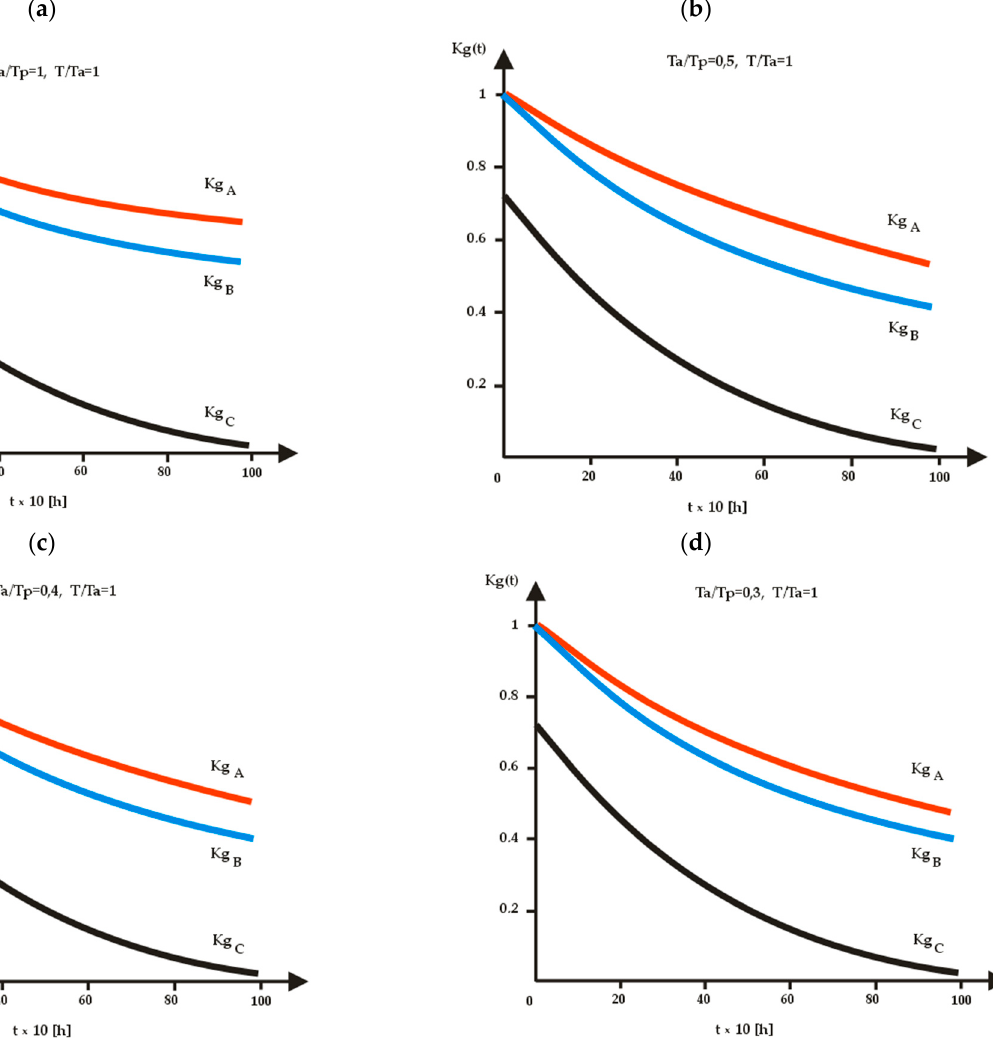
Figure 2. Courses for the readiness function Kg(t) of a wind power plant’s operation process that employs several forms of condition monitoring systems T/Ta = 1. Figure 2’s symbol represents: K g (t): availability capability; t: operating period; T a : time for immediate repairs; T P : the average length of planned repairs to wind power plants.